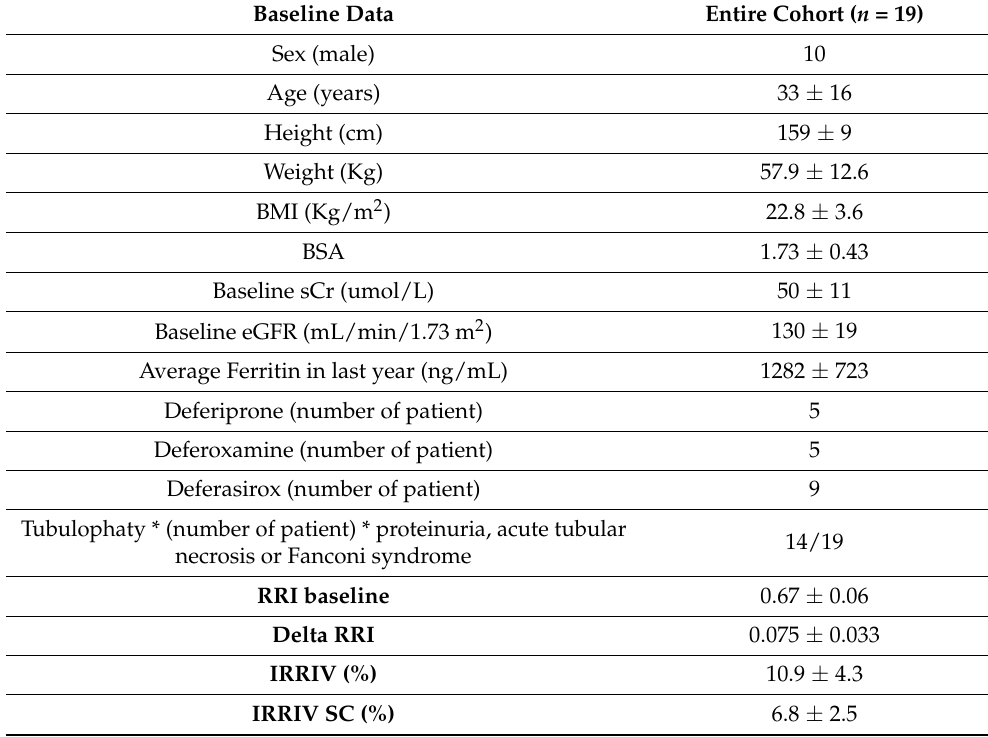
Table 1. Characteristics of patients at baseline and during